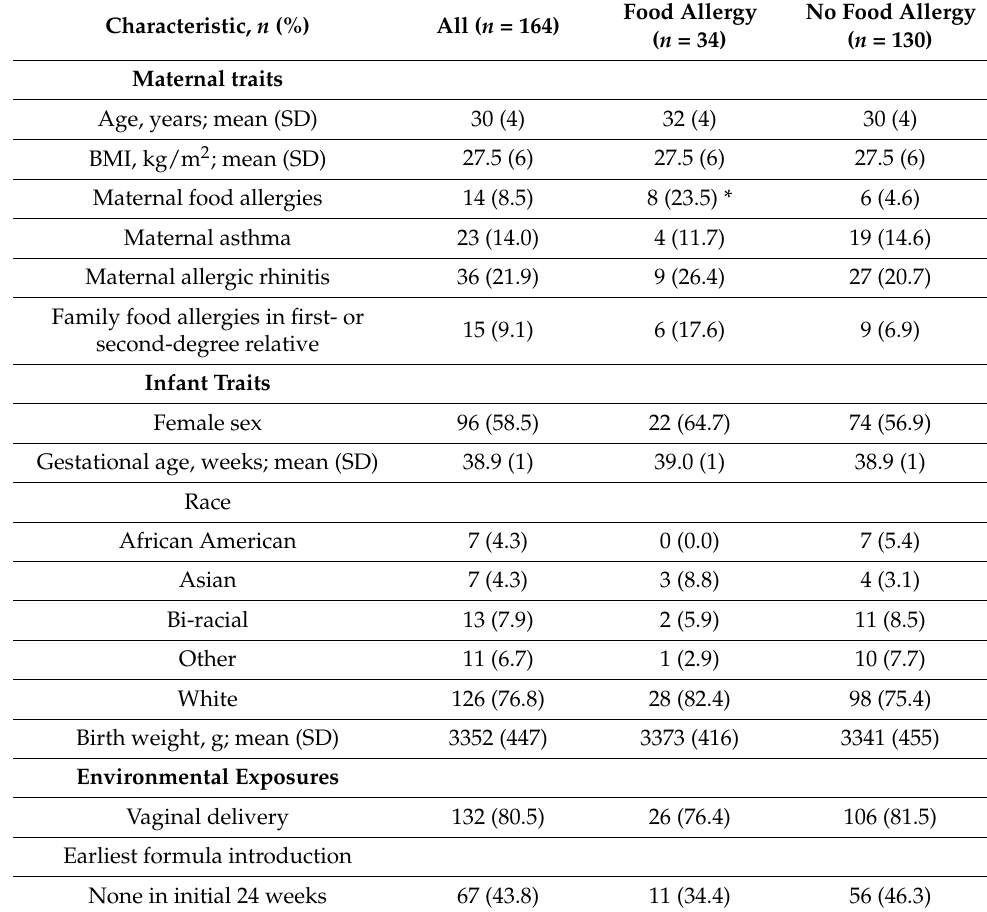
Table 1. Participant